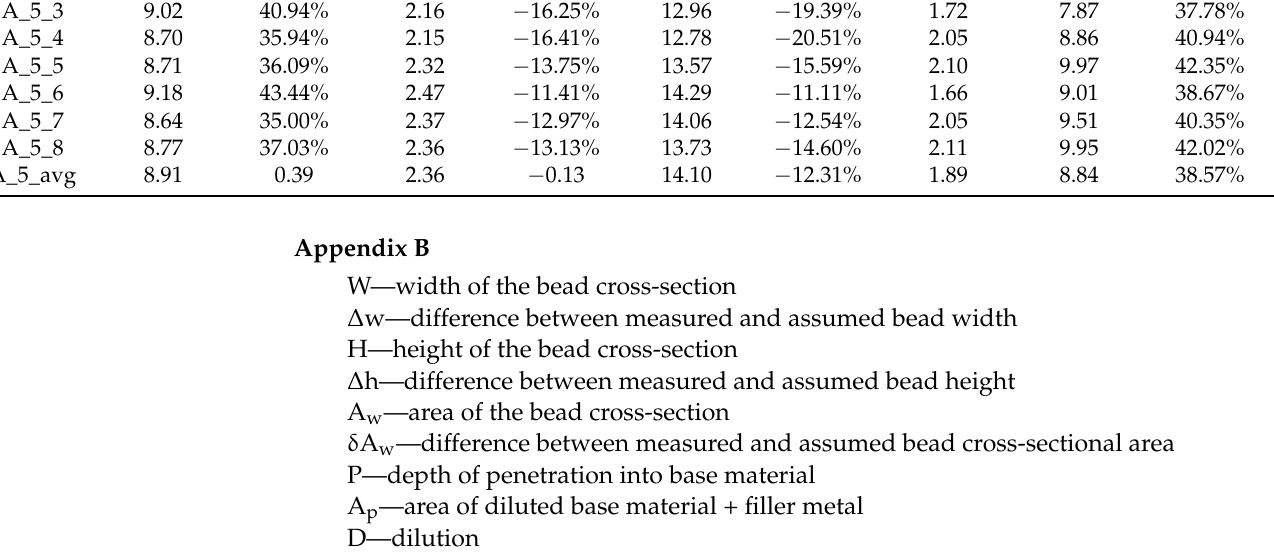
Table A6. Measurements of dimensional features of 1st parameter set of Wire B—wire